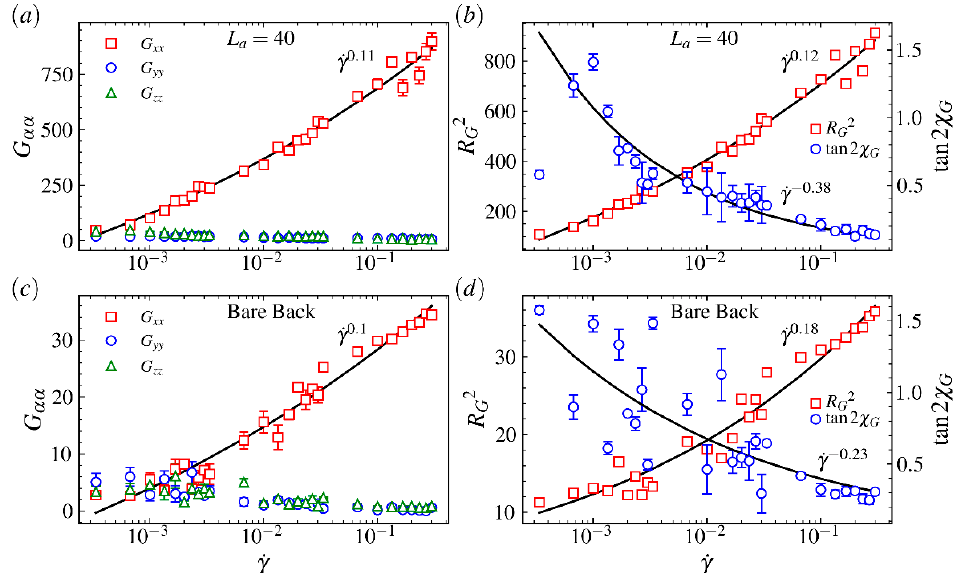
G , G ) and ( b , d ) squared radius of gy- G , xx zz yy χ as a function of Weissenberg number Wi G L = . a